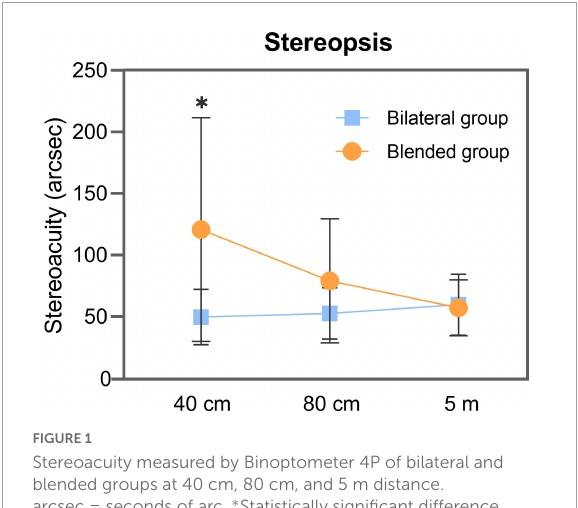
FIGURE1 Stereoacuity measured by Binoptometer 4P of bilateral and blended groups at 40 cm, 80 cm, and 5 m distance. arcsec = seconds of arc. ∗ Statistically significant difference between two